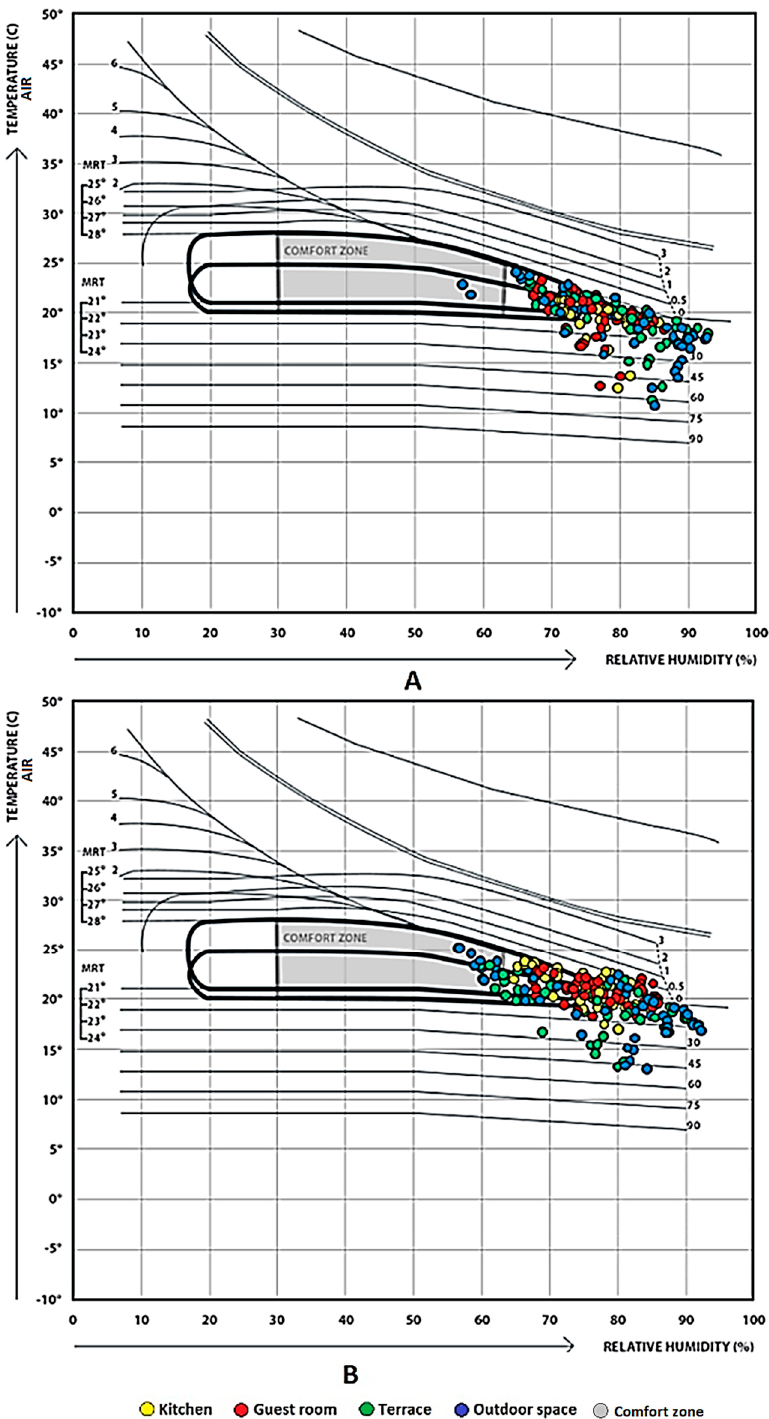
Figure 11. The Olgyay diagrams for exposed stone houses ( A ) and wooden houses ( B ) in the moun- tains.